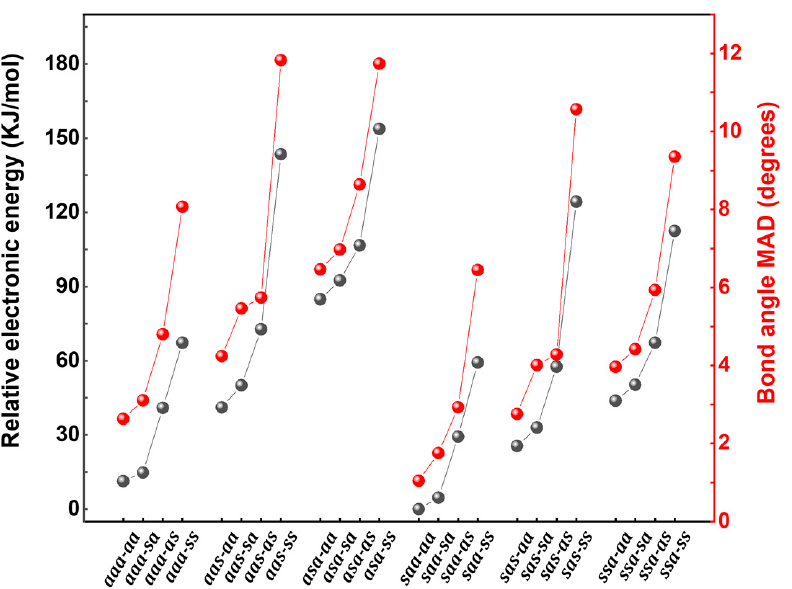
Figure 3. The C–C–C bond angle MADs and relative total electronic energies of the 24 conformers. The lowest 6 conformers were shortlisted for simulation of their 13 C NMR spectra.